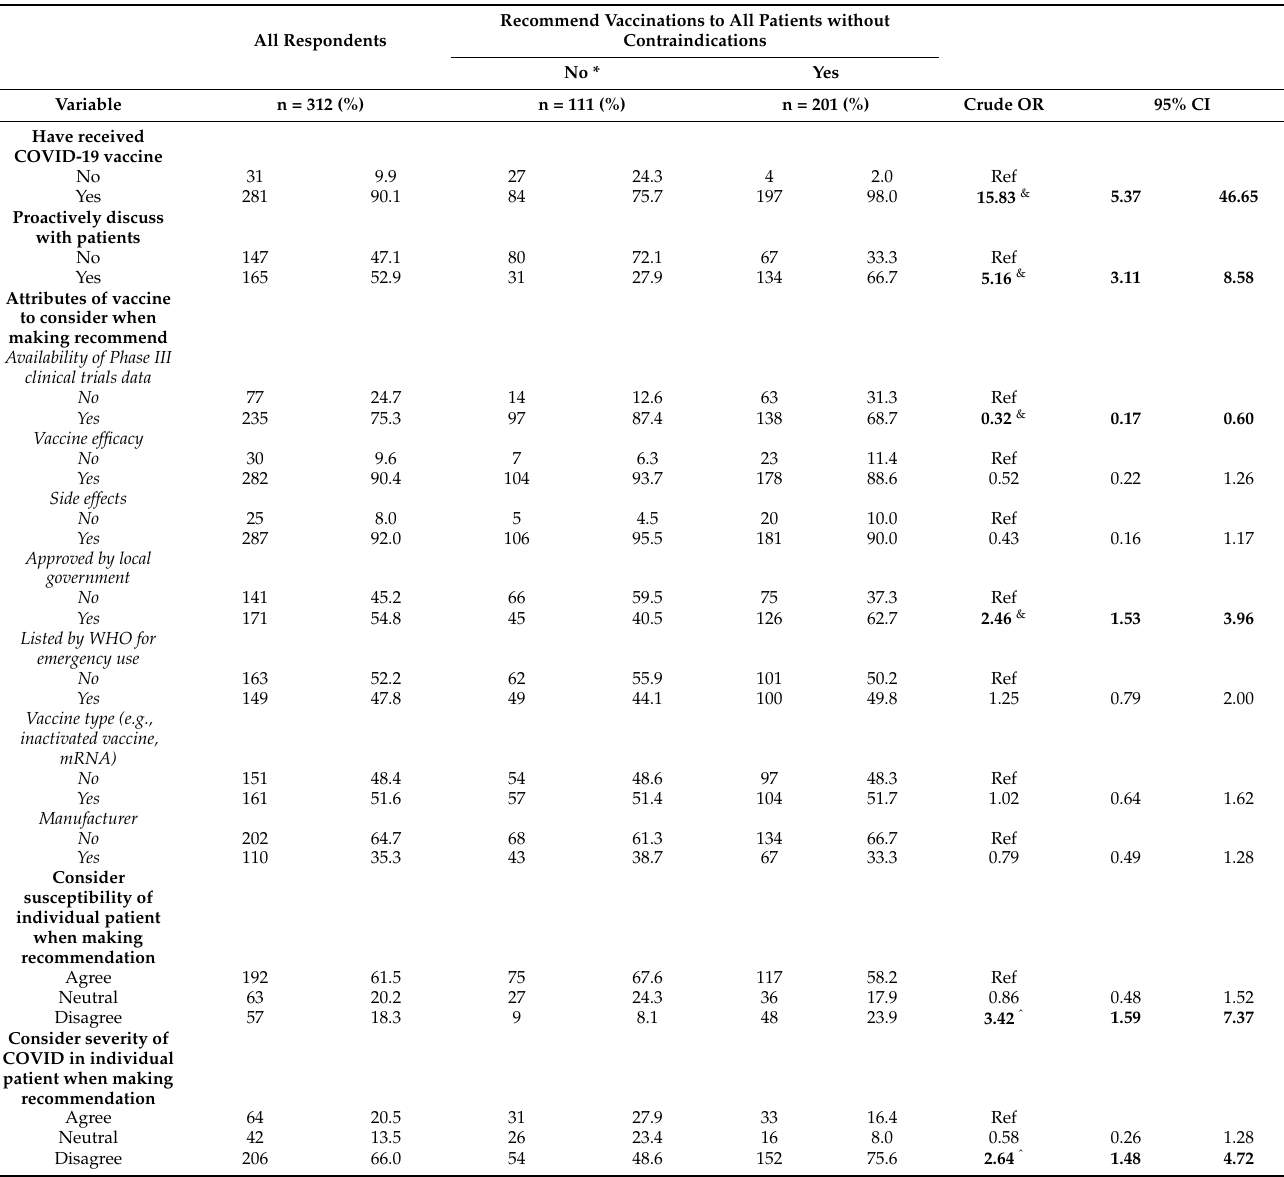
Table 3. Descriptive statistics and univariate analyses of factors associated with making COVID-19 vaccination recommen- dations to patients among family doctors (N =